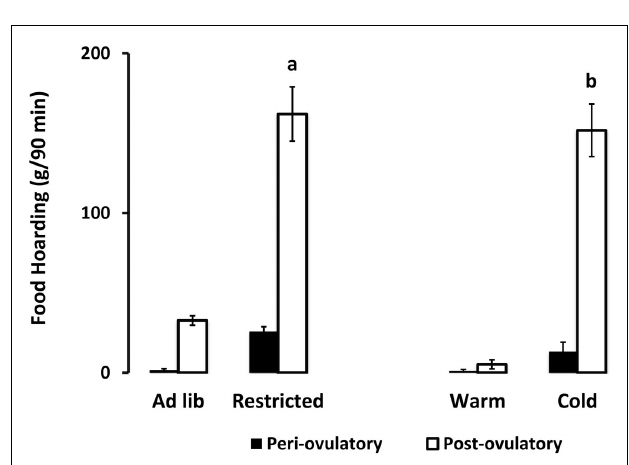
FIGURE 2 | Mean and SEM of food hoarding shown for females on either the periovulatory day (when circulating estradiol is high, black bars) or the postovulatory day when (circulating estradiol is low, white bars), in two experiments. Experiment 1 compared food-limited to food-unlimited females at 22˚C. Experiment 2 compared cold-housed (5˚C) to warm housed (22˚C) in females with unlimited food availability. a = significantly different from ad libitum -fed at P < 0.001, b = significantly different from warm housed at P < 0.001. Food-limited and unlimited groups adapted from Klingerman et al. (2010).